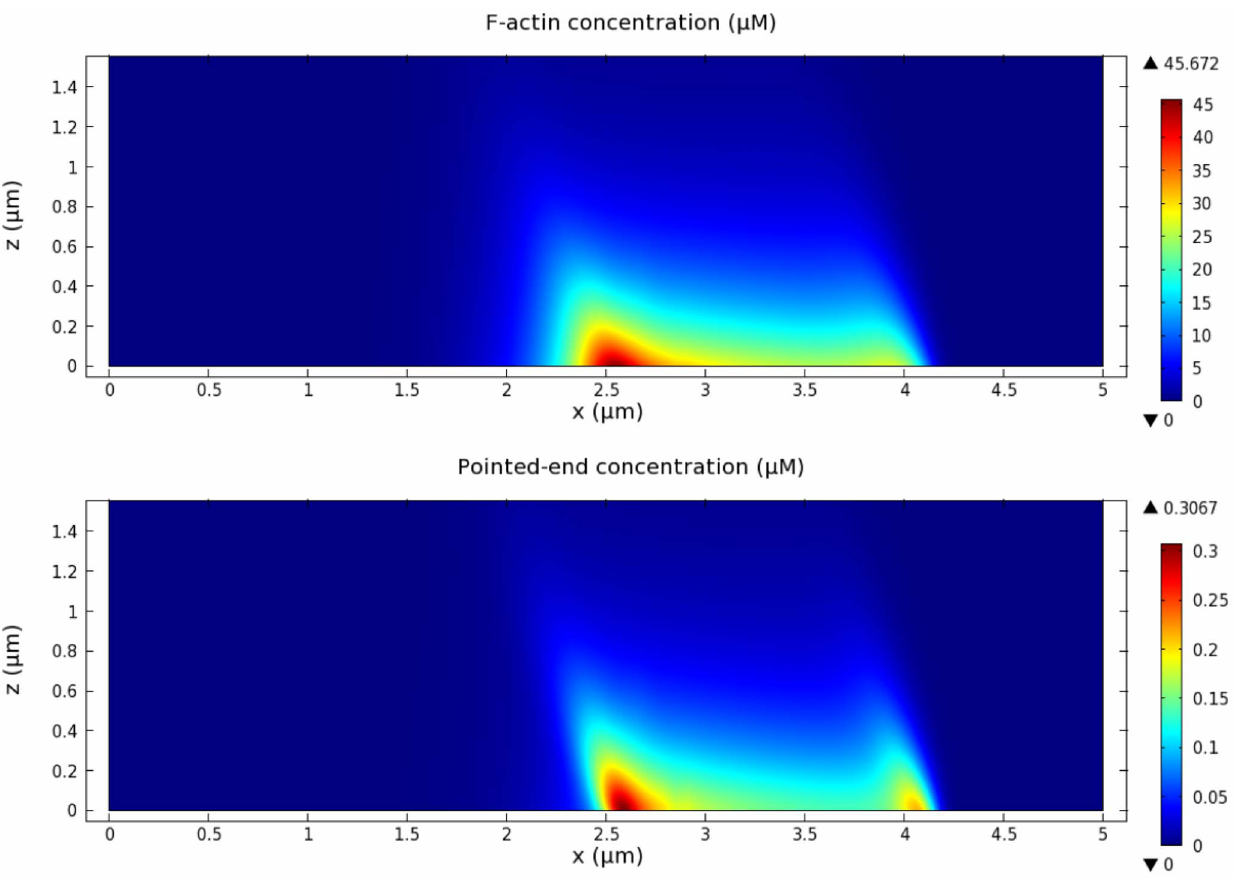
Figure 16. Actin structure of retracting waves. The actin density (upper) of the retracting actin waves at t ~ 35 s in Figure 15 corresponding to the total pointed-end density of the waves (lower).